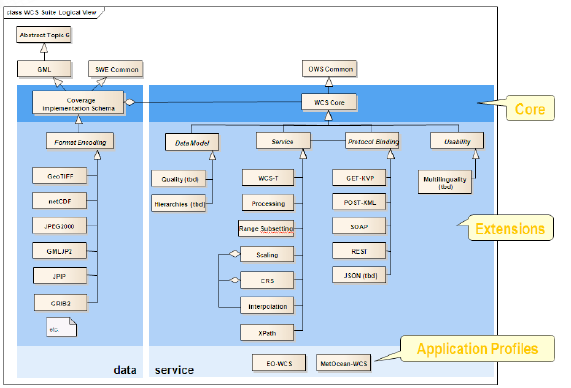
Figure 2. Web Coverage Service – Suite of Standards